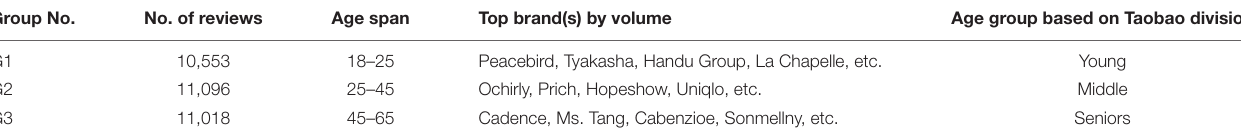
TABLE 1 | Data collection source.